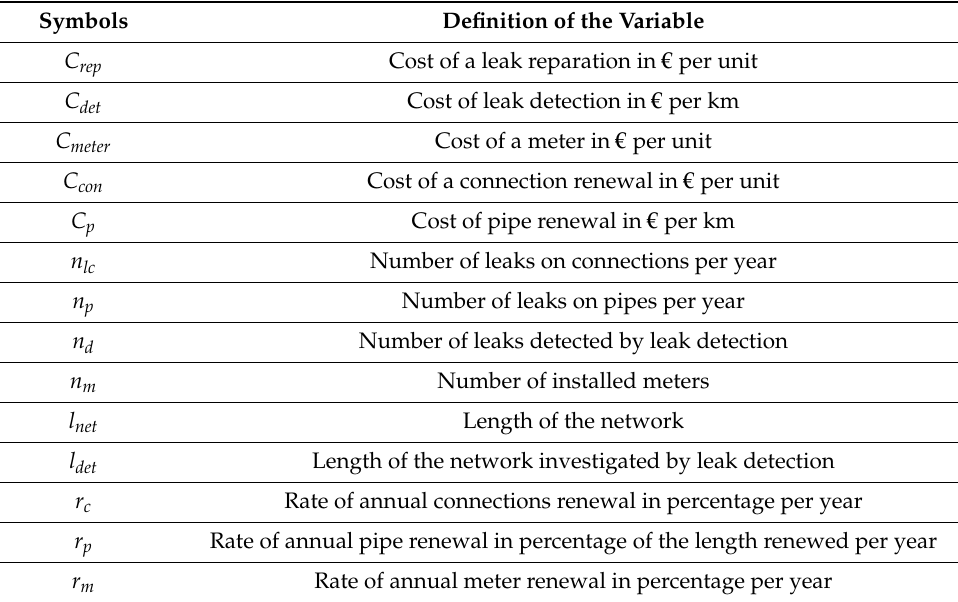
Table 3. List of required variables for cost